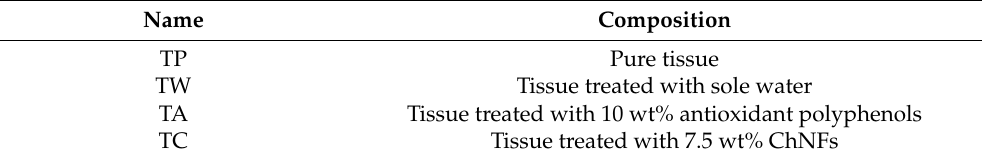
Table 1. Samples studied by mechanical tests.